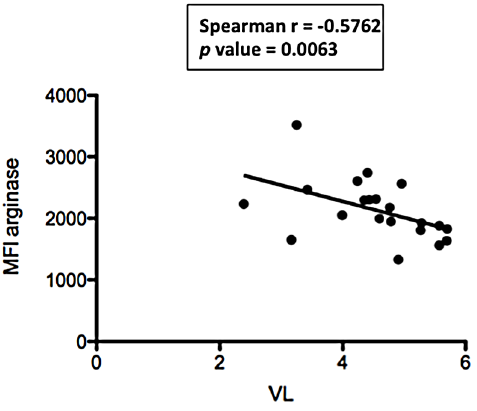
Figure 3. Correlation between viral load and phenotypic markers. NDGs were isolated from the blood of HIV + patients (n=21) as described in materials and methods and the expression levels of phenotypic markers were determined by flow cytometry. Correlation between viral load and phenotypic markers was determined by a Spearman’s rank